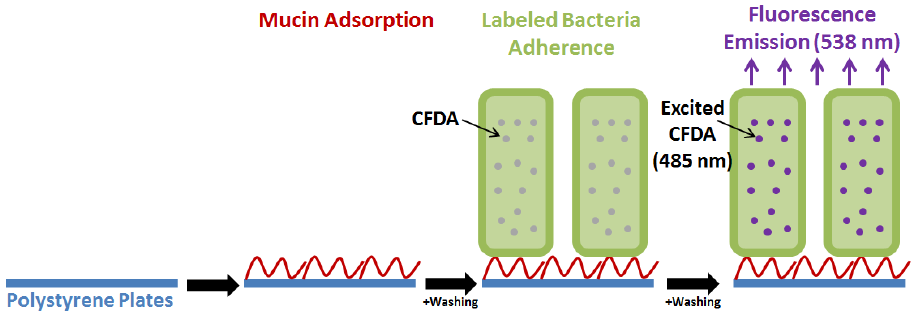
Figure 3. Mucin is adsorbed (or HT ‐ 29 cells are grown) onto polystyrene plates and added Lactobacillus acidophilus NCFM (OD at 600 nm = 0.5) labeled with carboxyfluorescein diacetate (CFDA). Following washing, the remaining fluorescence is determined after bacterial cell lysis as a measure of the amount of adhered bacteria [44,51].